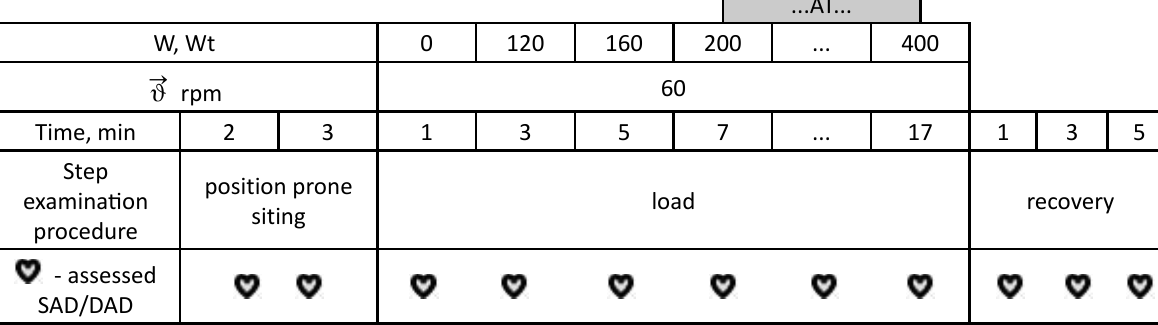
Figure 1. The protocol of the ergometer